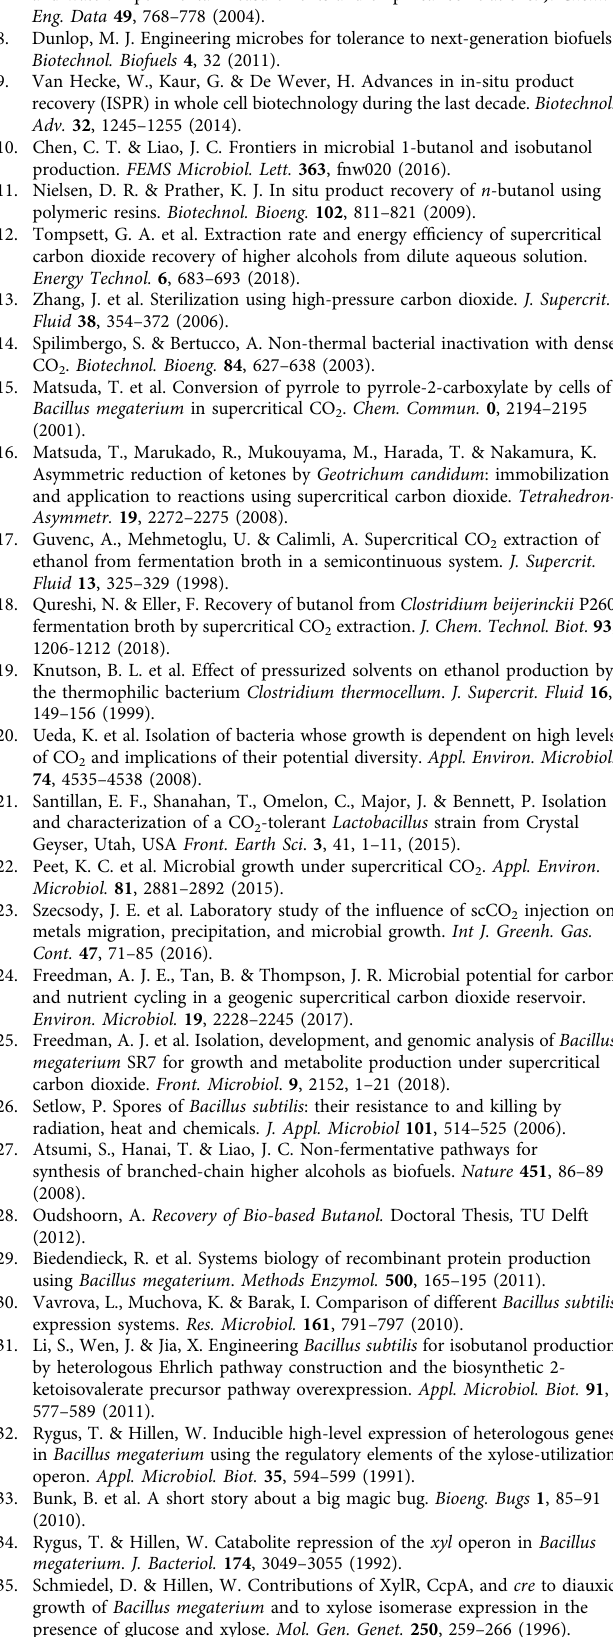
Fig. 15a, simpli fi ed process schematic: Fig. 5a). Preliminary calculations and comparison with published data 45,46 suggested use of the Soave-Redlich-Kwong equation of state to model phase equilibrium in all cases except for scCO 2 extraction of isobutanol, for which our own measurements on isobutanol were used in concert with literature data on n -butanol separation performance 43,44 . Ther- modynamic properties were modeled using the Lee-Kessler-Plöcker equation of state, as recommended by Aspen for supercritical fl uids. The process feeds were CO 2 at 0.1MPa and a stream of aqueous glucose (media and substrate). The water feed (P1) was pumped to 10MPa in a single stage. Consistent with typical engi- neering practice, CO 2 pressurization to 10MPa was completed in four stages (C1- 4), with each stage accomplishing a threefold pressure increase. In all cases, the thermodynamic ef fi ciency of the pumps/compressors was 85% and their mechanical ef fi ciency was 35%. Heat exchangers (HE1-3) were used to maintain CO 2 temperature at 40°C after compression and for feeding the fermenter. The fermenter was simulated as consisting of a continuously fed stirred tank reactor and a separator (V2) con fi gured in series. The reactor was modeled as achieving a steady state isobutanol concentration of 20g l – 1 , consistent with reported titers of isobutanol 27 . The entire contents of the reactor were fed to the separator (V2), a counter-current isobutanol extraction column 44 , which separated the feed into water-rich and CO 2 -rich streams. The isobutanol composition of the exit streams were set to that reported by Laitinen and Kaunisto 44 and modi fi ed using our performance data for isobutanol (i.e., 99.73% butanol recovery) and the exiting water and CO 2 streams were assumed to be at mutual saturation, using the data reported by King et al. 54 for binary mixtures. Downstream of the fermenter, a three-phase separator (V3) was used to decrease the pressure to permit the separation of isobutanol-rich, water-rich, and CO 2 -rich streams, as suggested by